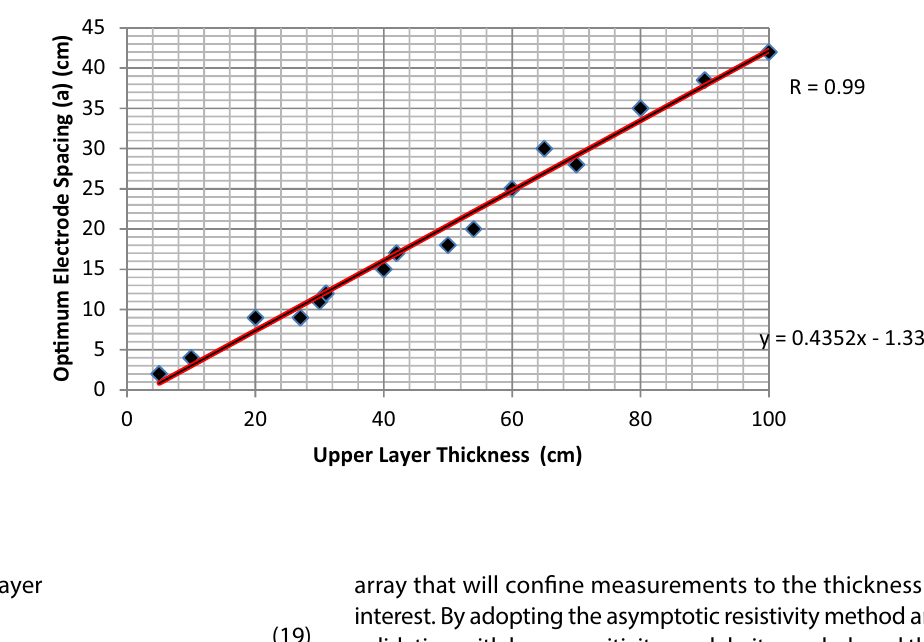
Fig. 8 Analytical chart for deterministic electrode spac- ing for upper layer resistivity